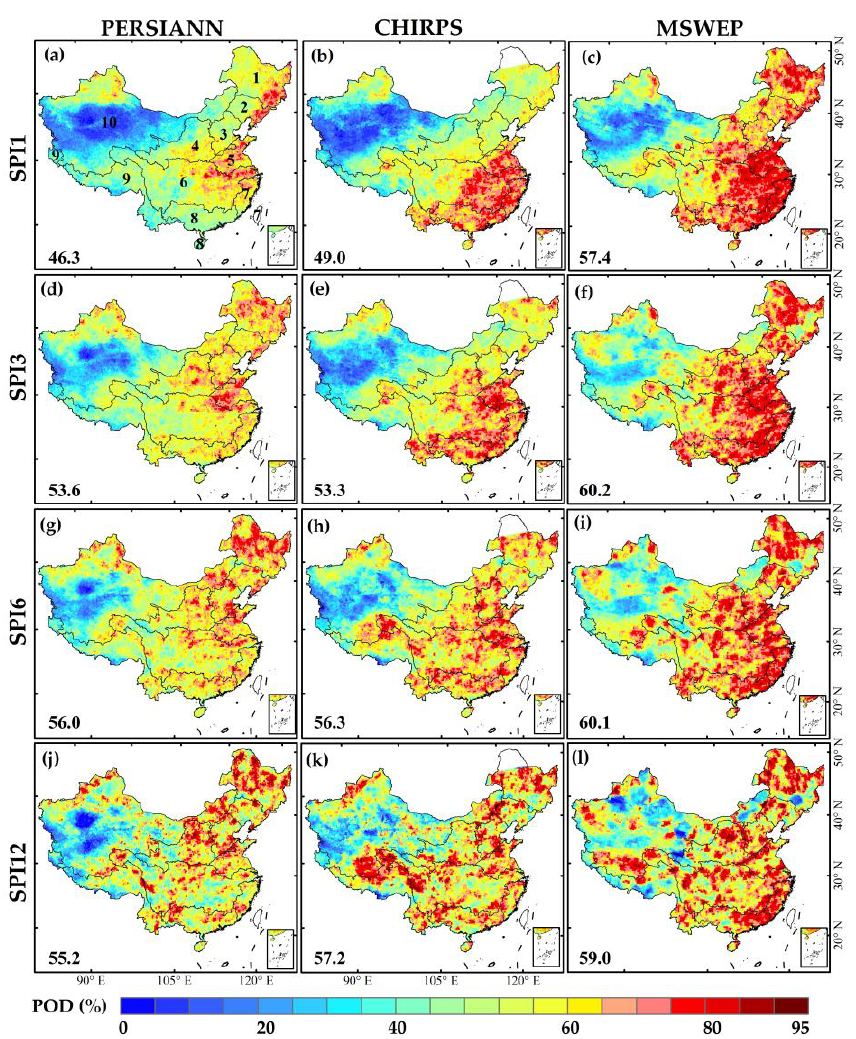
Figure 9. Spatial distribution of POD estimated from three RSPEs. ( a , d , g , j ) PERSIANN. ( b , e , h , k ) CHIRPS. ( c , f , i , l )MSWEP. The numbers in ( a ) indicate: 1—the Song Hua River, 2—the Liao River, 3—the Hai River, 4—the Yellow River, 5—the Huai River, 6—the Yangtze River, 7—southeastern rivers, 8—the Pearl River, 9—southwestern rivers, 10—northwestern